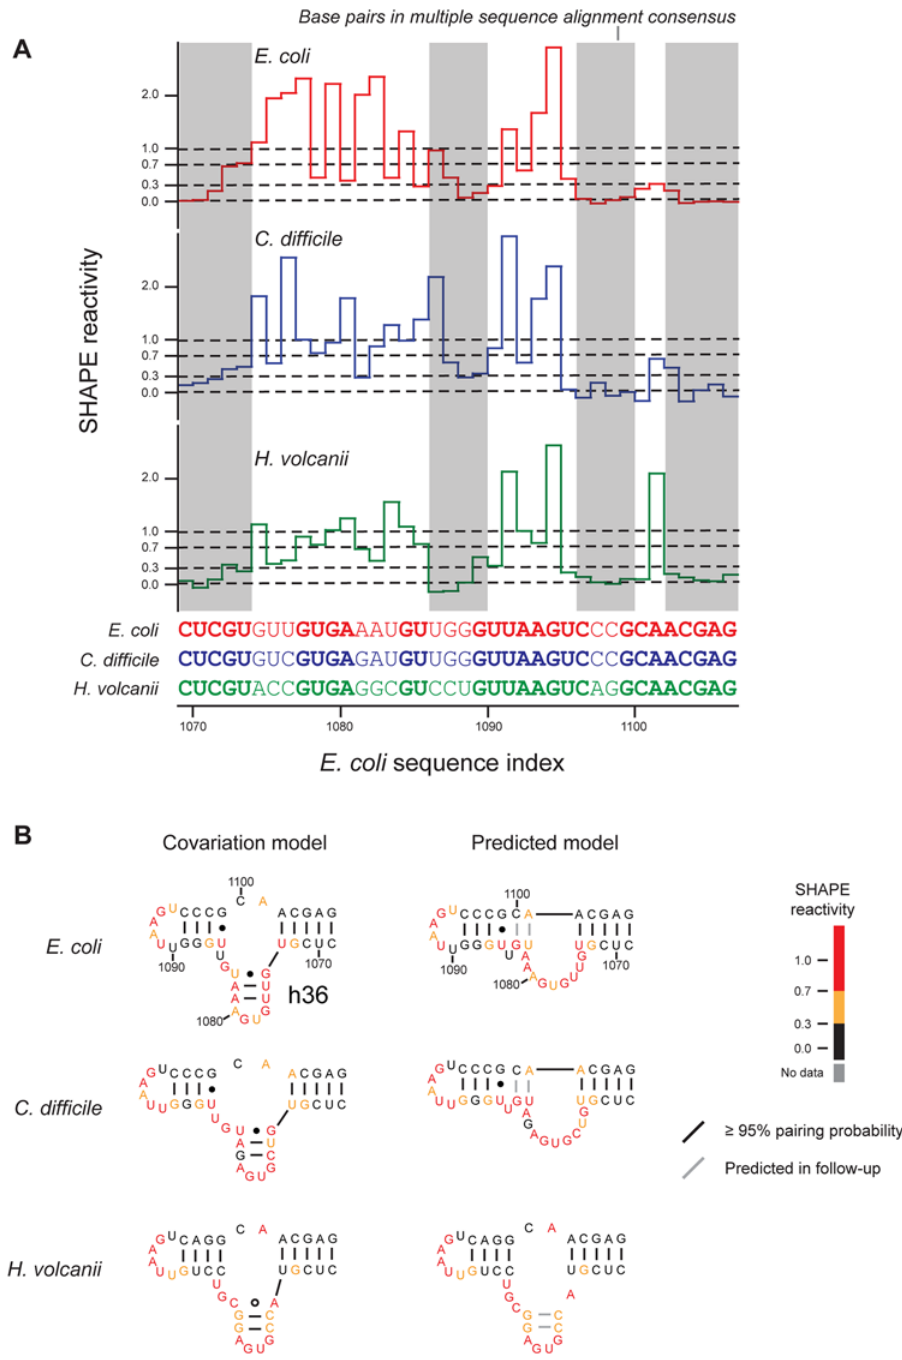
Fig 4. Consensus alternate structures for helix 36 of E . coli 16S rRNA. ( A ) SHAPE reactivities for aligned regions with consensus areas (RNAalifold) highlighted in gray. ( B ) Structures for the covariation and SHAPE- structure constrained models. Base pairs predicted in the first-step (RNAalifold) consensus are black, and base pairs predicted in the follow-up constrained (RNAfold) prediction are shown in gray.